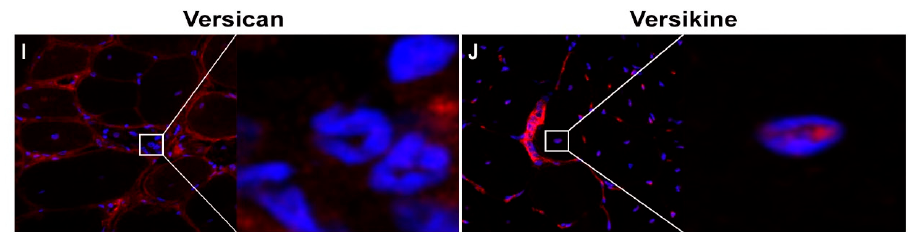
Figure 3. Versikine is localised to regenerating myofibres and mononuclear infiltrate, as well as within nuclei in mdx TA muscles. Serial cross-sections were stained with versican or versikine and desmin, phase images were captured to confirm localisation and tissue orientation. ( A – D ) Versican was localised to interstitium between myofibres. ( E – H ) Versikine was highly expressed in regenerating muscle, as indicated by its association with small desmin positive, centrally nucleated myofibres. ( I , J ) In dystrophic muscle cross-sections, nuclear localisation of versikine, but not versican, was also observed. Scale bars = 100 µm.